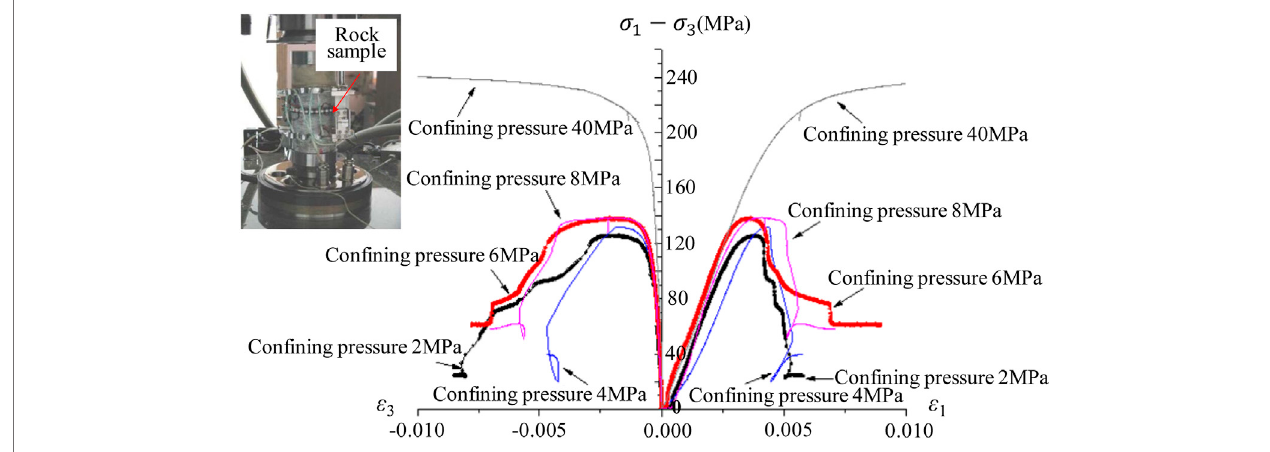
FIGURE 4 | Triaxial compression tests of Jinping T 2b marble